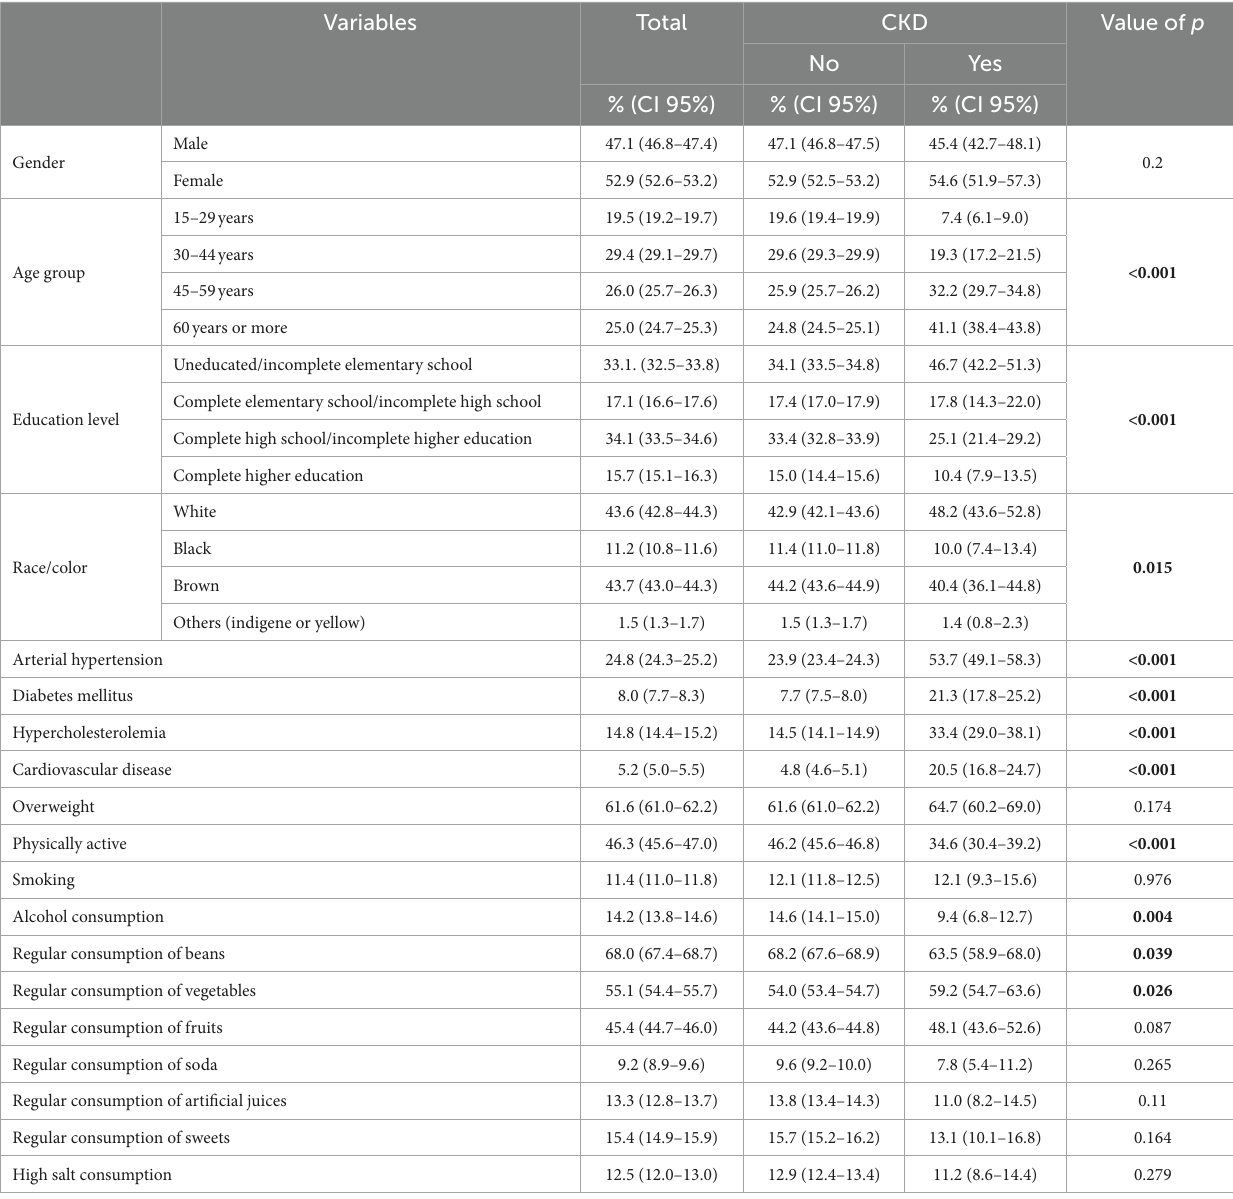
TABLE 1 Sociodemographic characteristics and prevalence of metabolic and behavioral factors, according to the presence of CKD. PNS,